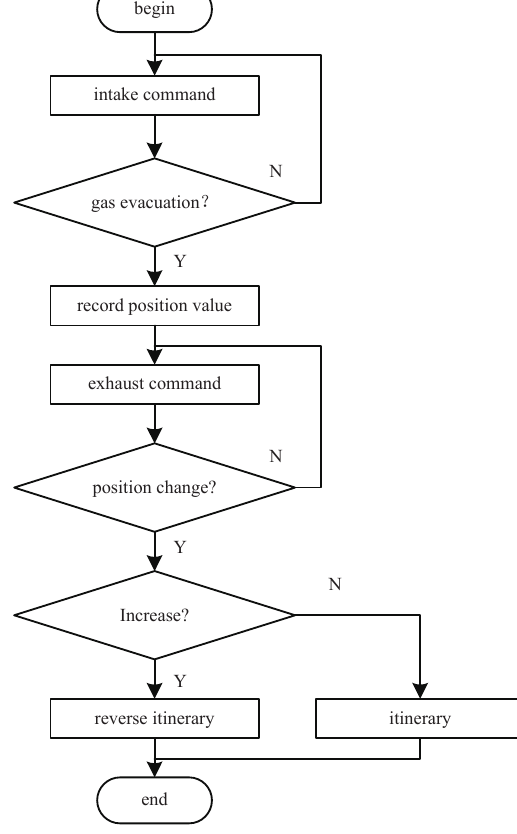
Figure 7. Flowchart of stroke type